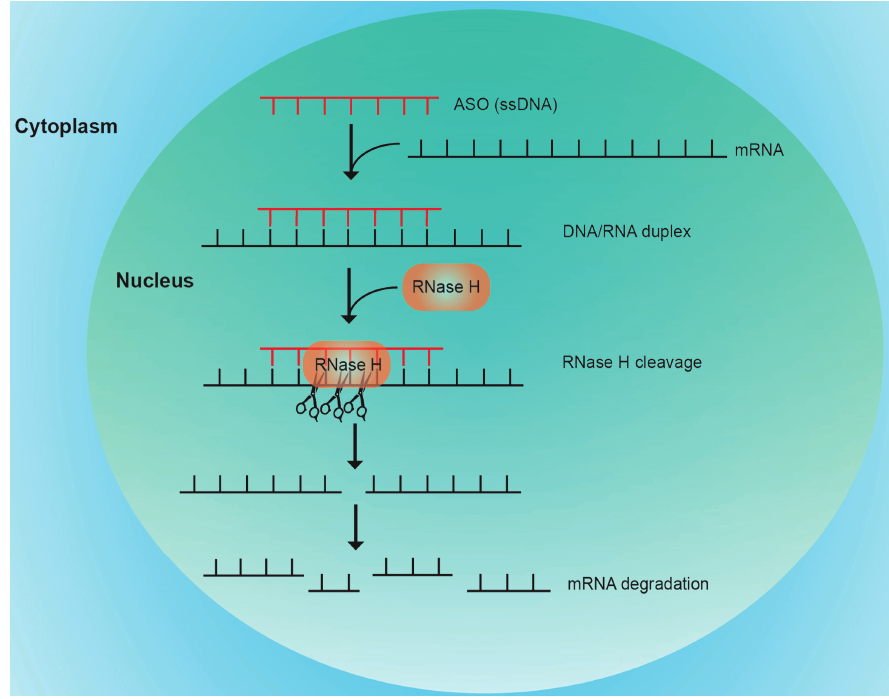
Figure 2. Schematic representation of ASO mediated gene silencing via RNase H